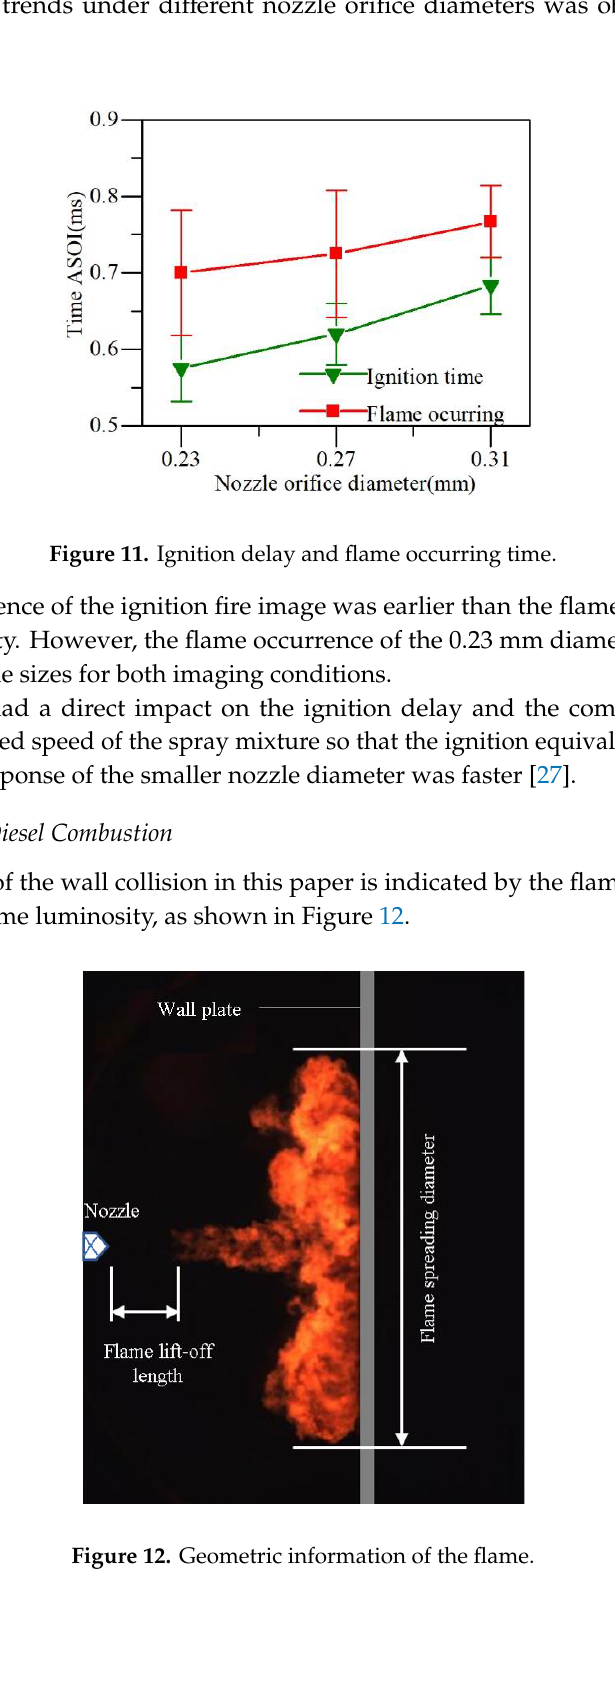
Figure 12. Geometric information of the flame.